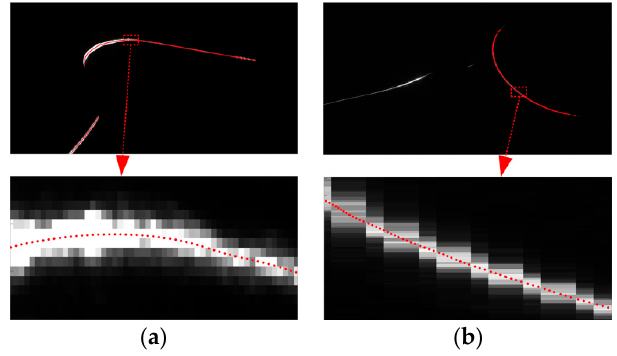
Figure 6. The image processing result of Figure 5. ( a ) The result of Figure 5a; ( b ) the result of Figure 5b.